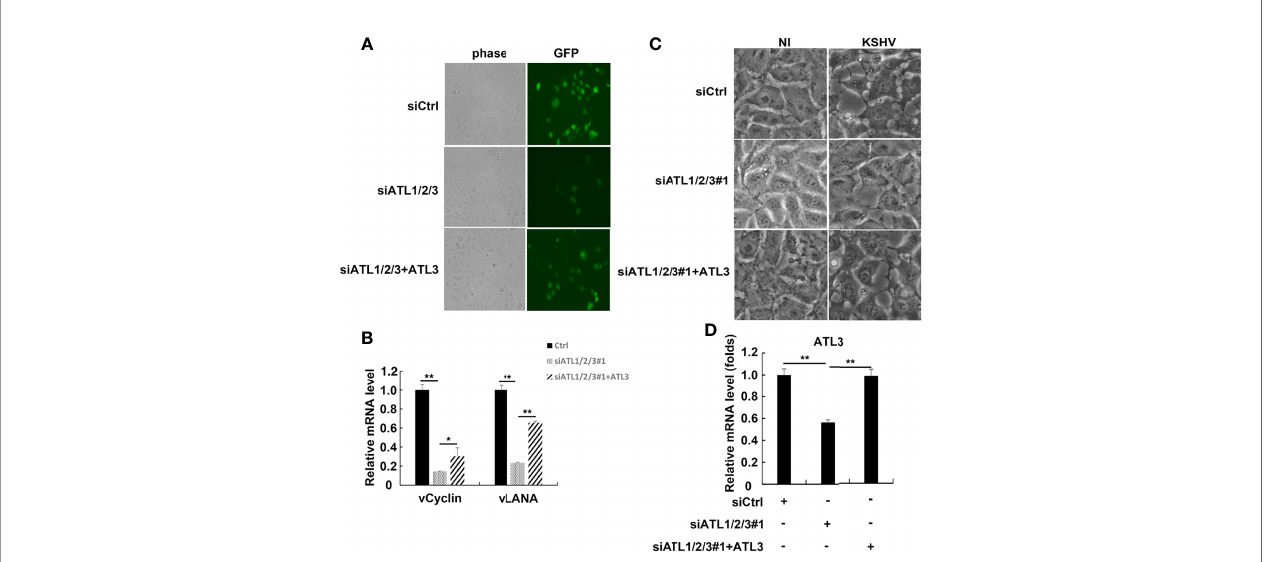
FIGURE 8 | Silencing of ATL impairs KSHV de novo infection in HUVEC cells. HUVEC cells were transfected with siCtrl, siATL1/2/3#1 or siATL1/2/3#1 plus ATL3 respectively followed by infection with rKSHV219 for 24 h (A) The cells were photographed for GFP fl uorescence. (B) mRNA levels of KSHV latent genes vCyclin and vLANA were measured by RT-qPCR, with normalization to actin using the DD CT method. (C) Virus-induced vacuoles were observed by light microscopy. (D) Knockdown ef fi ciency of siATL1/2/3 and replenishment ef fi ciency of ATL3 in HUVEC cells were measured by RT-qPCR. Data are presented as means of three technical replicates (n=3, group values are indicated by mean ± SEM; *p < 0.05; **p < 0.01).